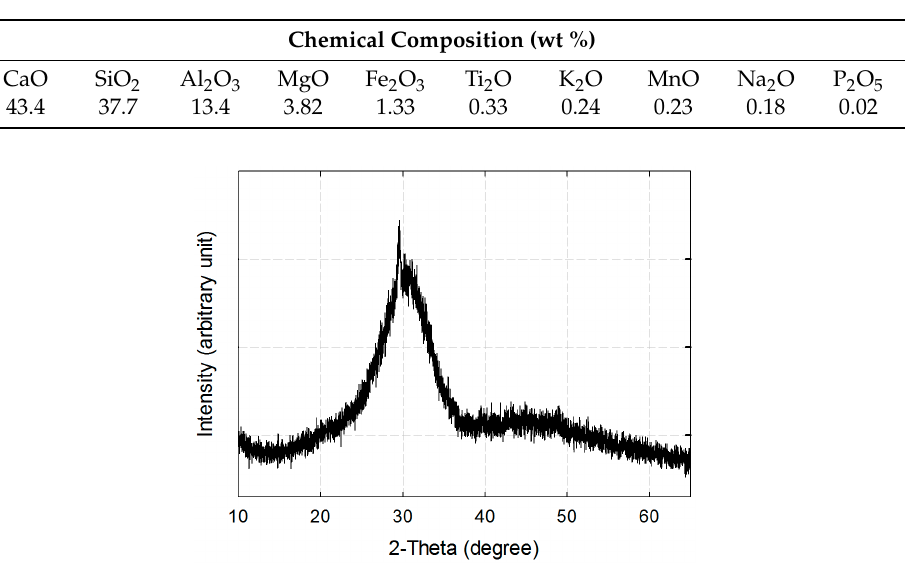
Figure 1. X-ray diffractogram of blast furnace slag analyzed by a step-scan mode.